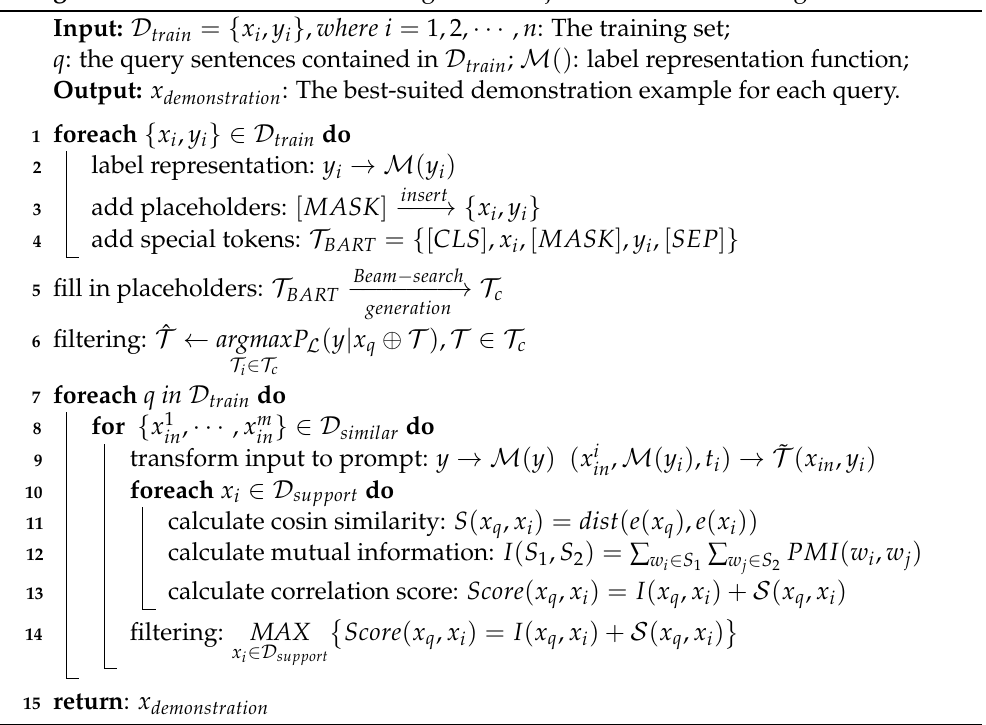
Algorithm 1: Demonstration filtering based on joint correlation